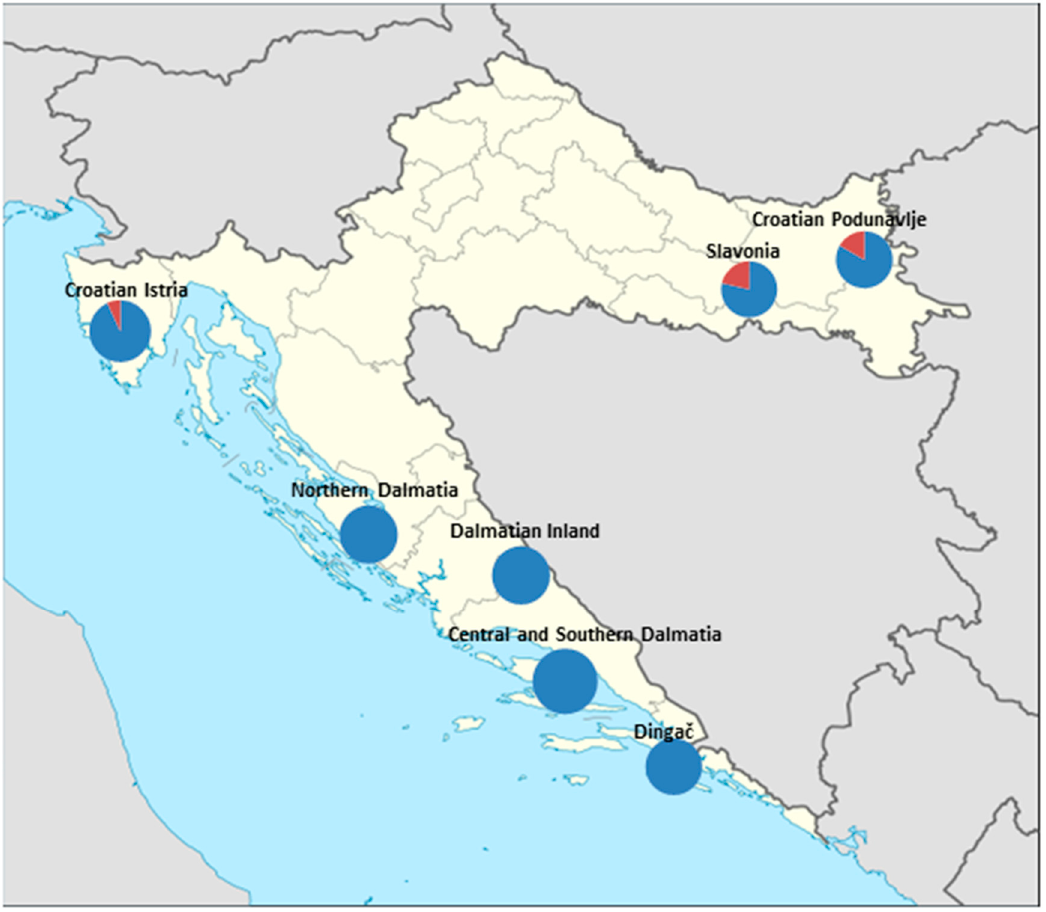
Figure 1. Incidence of contaminated samples according to geographic origin (contaminated-blue; non-contaminated-red).